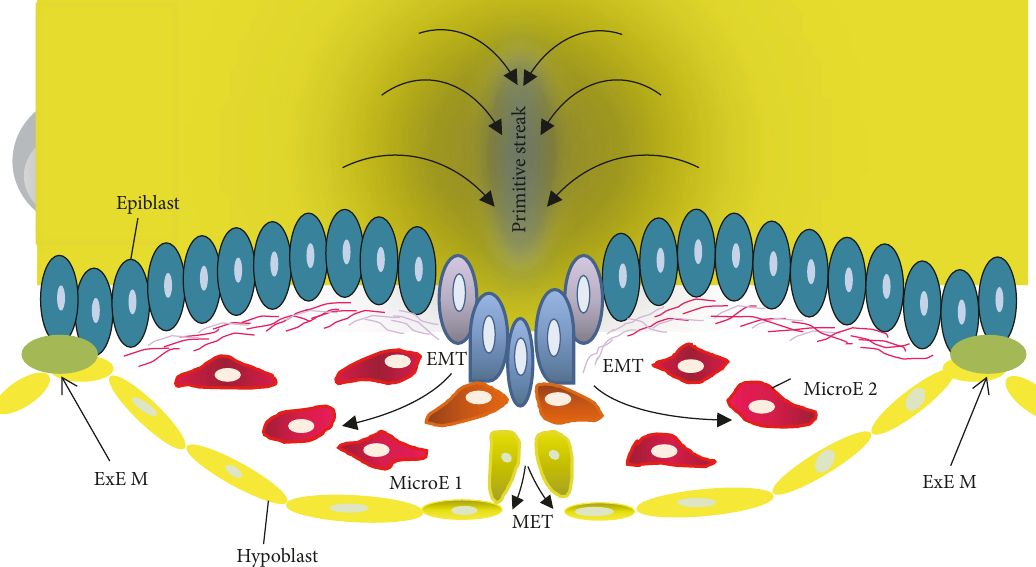
Figure 3: Human gastrulation. During gastrulation, epiblast cells at the primitive streak undergo Epithelial-Mesenchymal Transition (EMT) as a result of signals produced by the Spemann organizer or internal determinants. The migratory mesenchymal cells are interacting with the embryonic context in a different way: microenvironment 1 (MicroE 1), only with the hypoblast, exactly, in the middle region of the embryo. Microenvironment 2 (MicroE 2), simultaneously with the hypoblast and the extraembryonic mesoderm (EXE M) in lateral ends of the embryonic disc. Adapted from Micalizzi et al.,